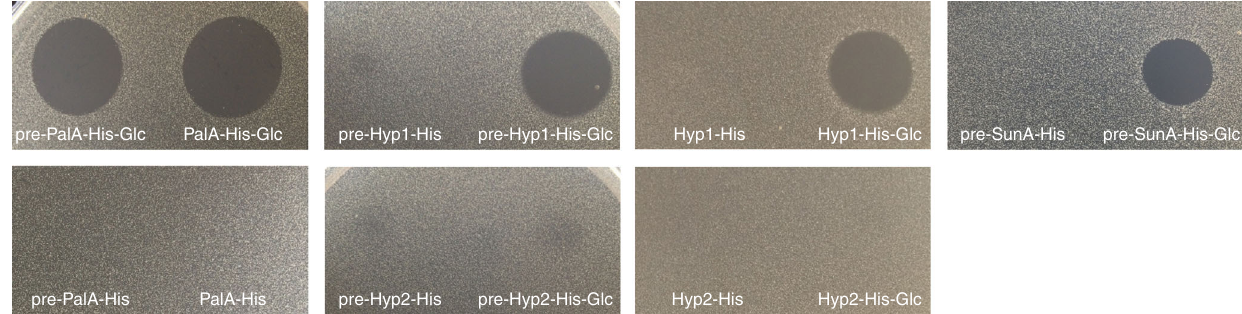
Fig. 3 Antibacterial activities of synthesized and puri fi ed peptides. The peptides were derived after coexpression of glycocin precursors with PalS/PalT/ PalST proteins in E. coli , subsequent puri fi cation by Ni 2 + af fi nity chromatography (IMAC) and RP-HPLC. Antibacterial activity was indicated as a clearly visible inhibition zone of sensitive strain P. genomospecies 1 NUB36187 and assessed by a spot on a lawn assay